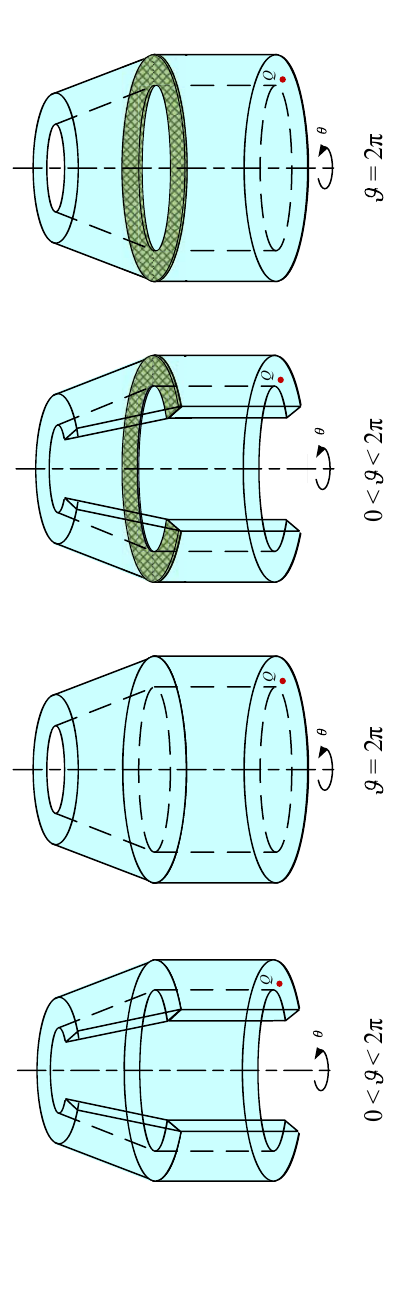
Figure 2. Unified model of the coupled